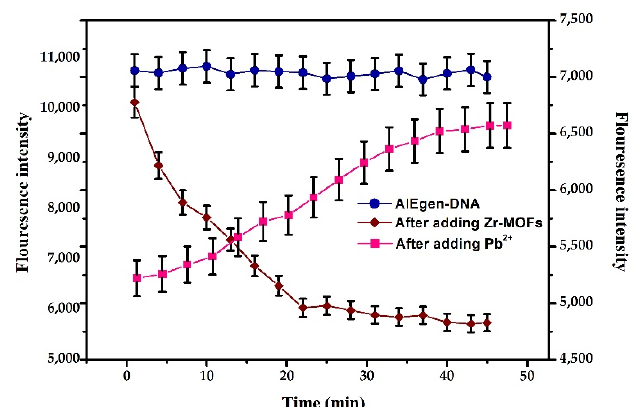
Figure 6. Changes in fluorescence intensity with time after adding different substances, the blue lines (AIEgen-DNA) and brown lines (After adding Zr-MOFs) correspond to the vertical axis on the left, and the pink lines (After adding Pb 2+ ) correspond to the vertical axis on the right.